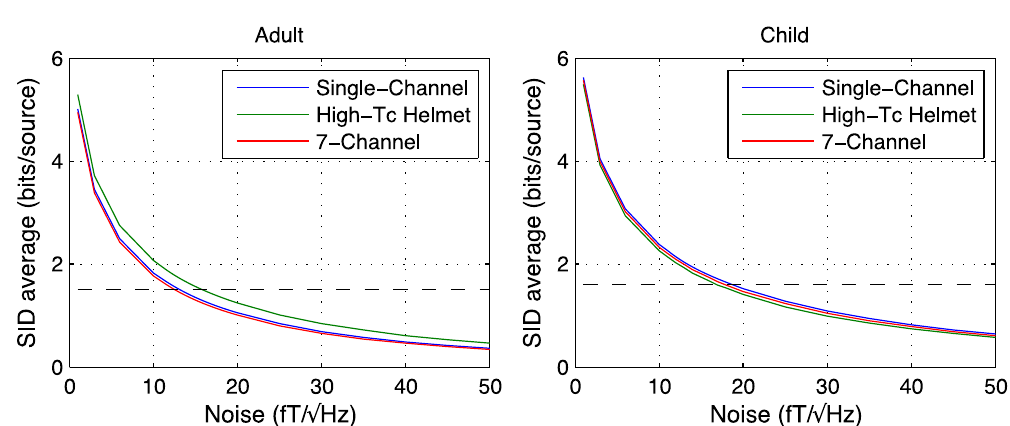
Figure 3. SID avg for three on-scalp arrays as a function of sensor noise levels for recordings on the adult (left) and child (right). The dashed, horizontal line is SID avg for the Elekta helmet array (with sensor noise levels of 3 fT/ √ Hz) for comparison (1.5 bits/source for the adult, 1.6 bits/source for the child). Intersections between the on-scalp SID avg lines and this reference line indicate noise levels required to reach the performance of the Elekta system with respect to average sampling of independent